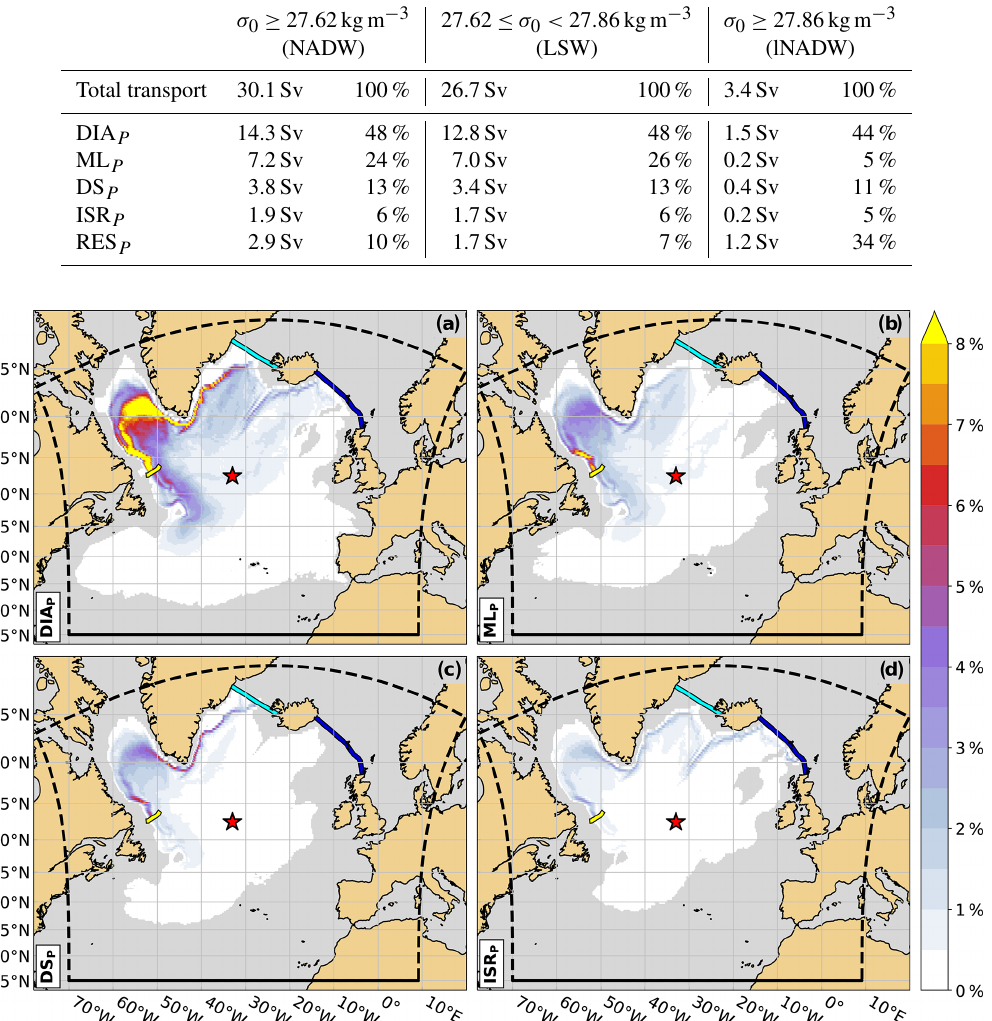
Figure 3. Particle pathways associated with most of the volume transport, calculated as transport-weighted probability density maps (1 / 4 ◦ × 1 / 4 ◦ bins) of the different particle categories: (a) DIA P , (b) ML P , (c) DS P , and (d) ISR P (see Sect. 2.1.3 for details of the definitions). The Charlie–Gibbs Fracture Zone is indicated by the red star. The yellow line marks the 53 ◦ N section, and the light and dark blue lines mark the Denmark Strait and Iceland–Scotland Ridge sections, respectively. The dashed black line indicates the boundary of the experiment